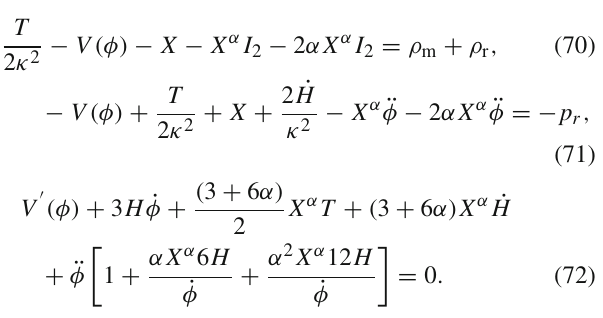
respect to φ , presented in Eq.